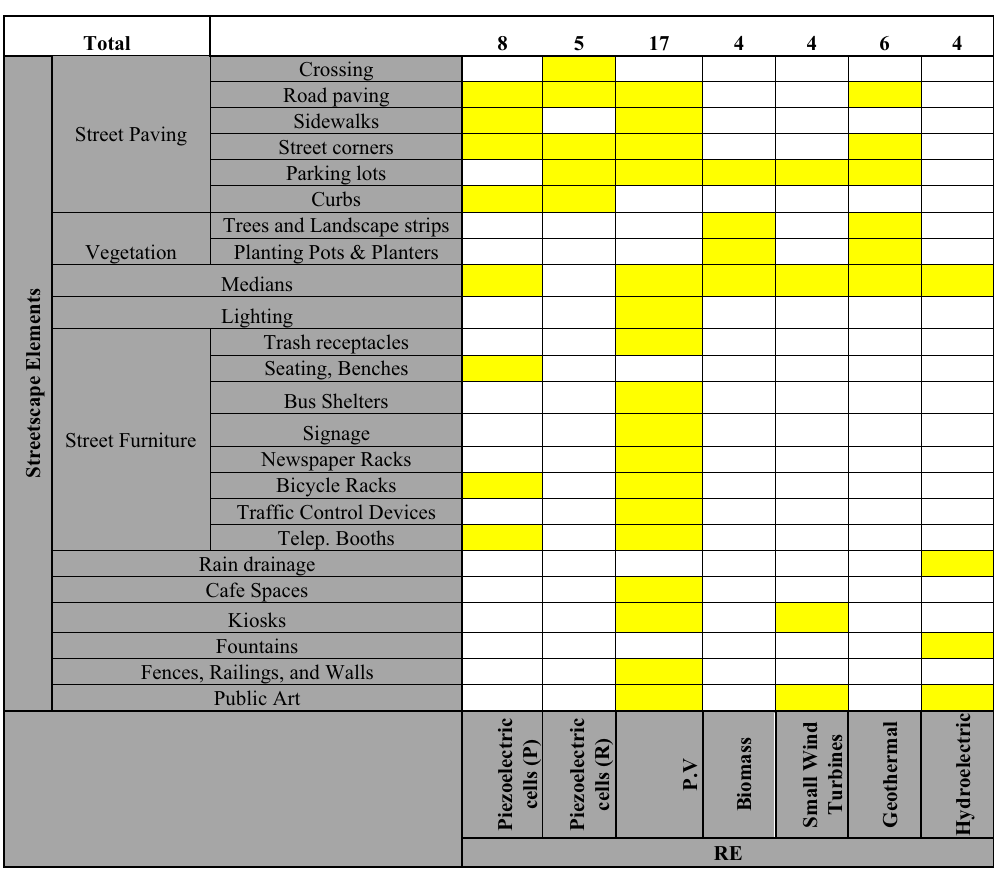
Table 1. Relation matrix between streetscape elements and RE.